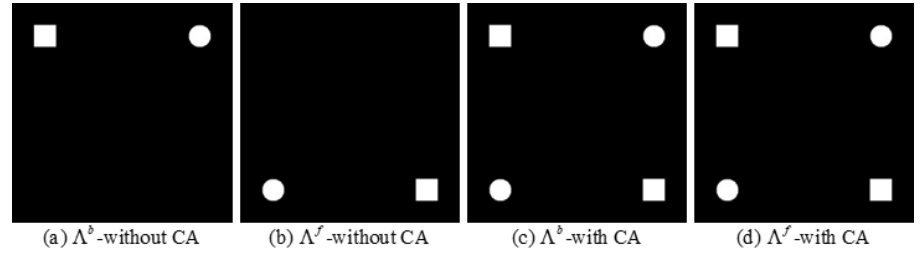
Figure 3. Alignment of difference maps. ( a ) Λ b without the change alignment process. ( b ) Λ f without the change alignment process. ( c ) Λ b with the change alignment process. ( d ) Λ f with the change alignment